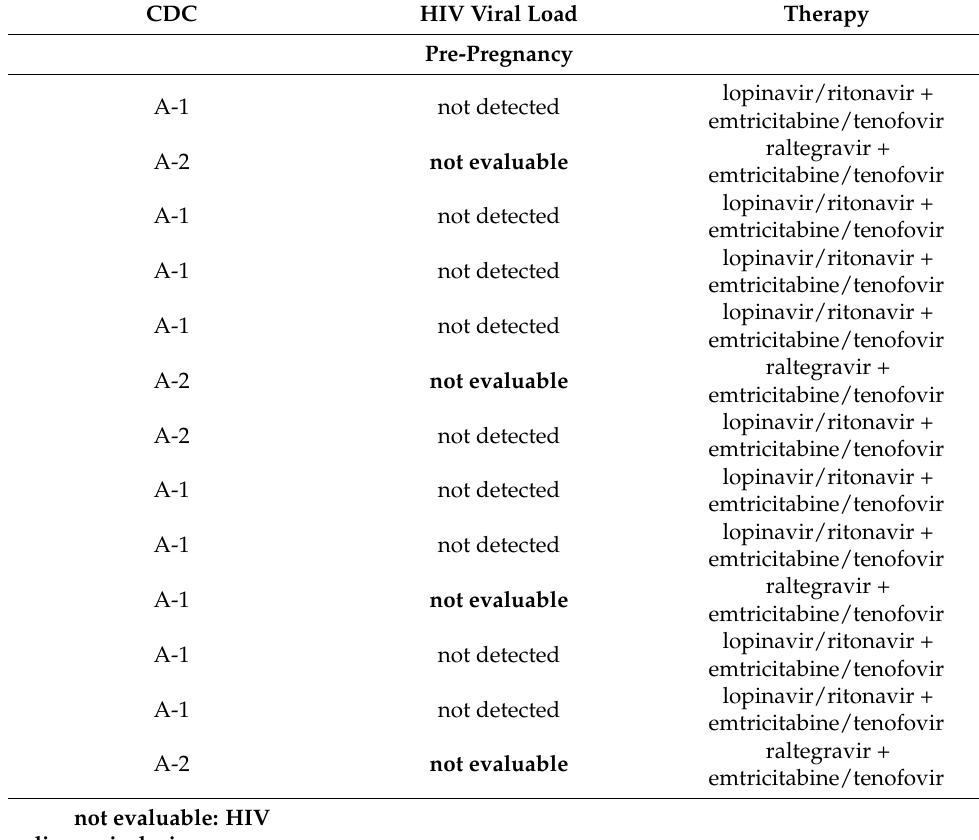
Table 3. Pre-pregnancy viral load and therapeutic scheme of 13 cohort female